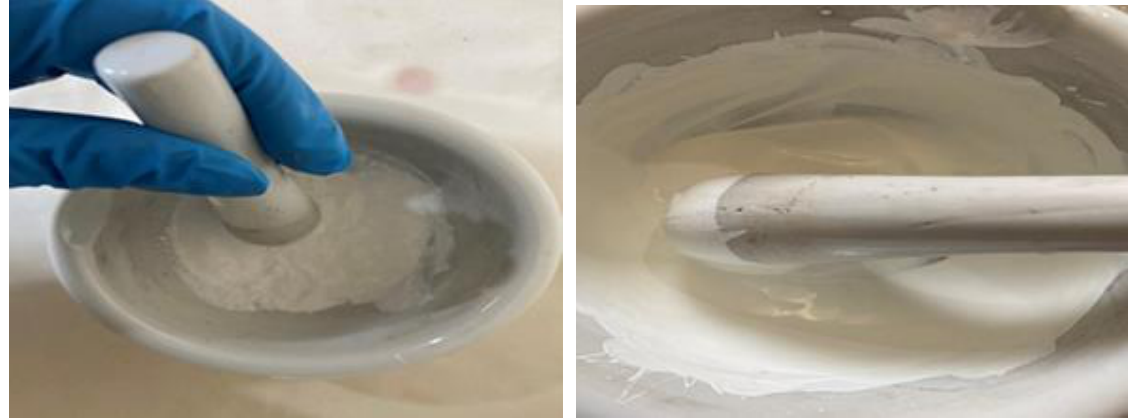
Figure 2. Photograph for TiO 2 preparation process and its texture.